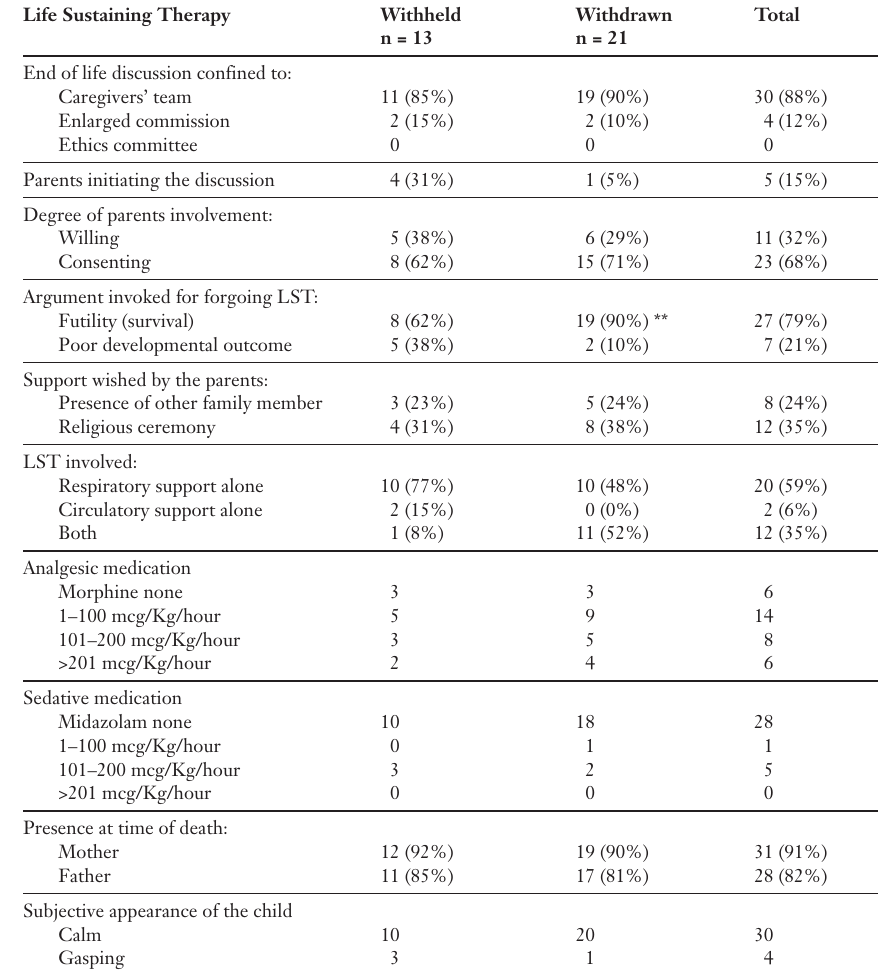
Practical aspects in infants whose LST was